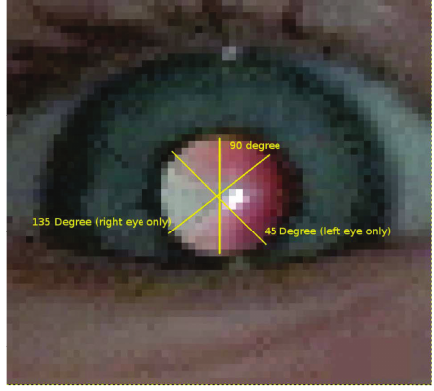
Figure 4. Pixel color extraction.